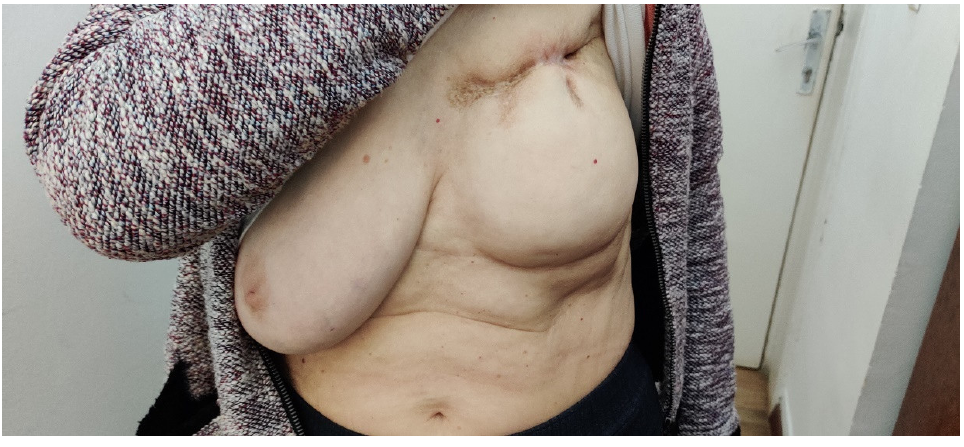
Figure 6. Clinical presentation of the left breast in March 2023.